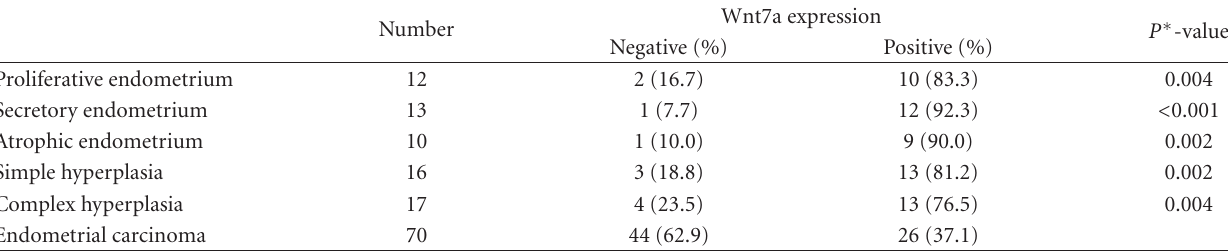
Table 2: The expressional profile of Wnt7a in endometrial carcinoma and its precursor lesions.